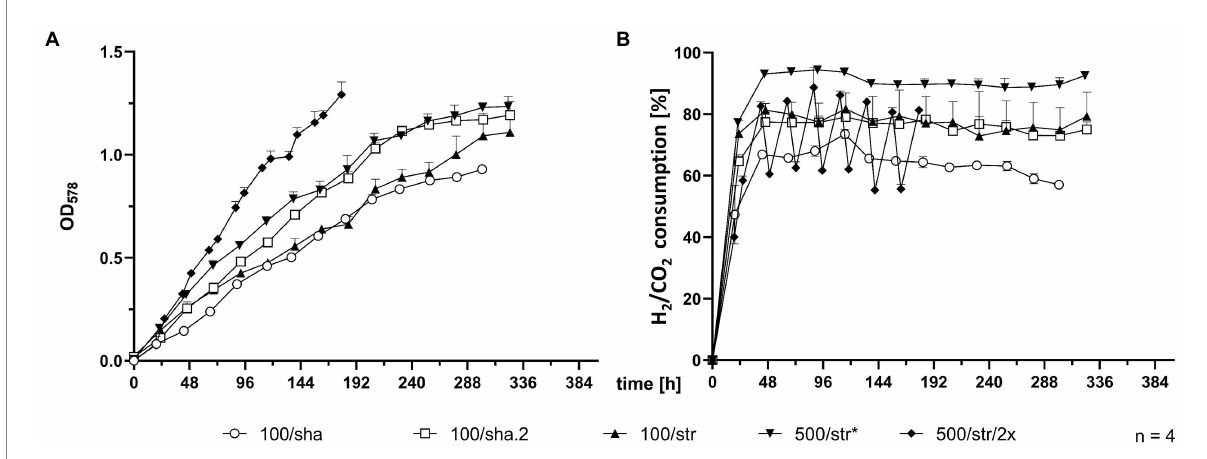
FIGURE 1 Comparison of 0.05 L SB cultures. (A) OD 578 measured over time in h. (B) substrate consumption, measured in % conversion of substrate (H 2 /CO 2 ) into product (CH 4 ) over time in h. All data points are calculated mean values of biological quadruplicates ( n = 4). Further details are presented in Table 1. * n = 3 after t = 277